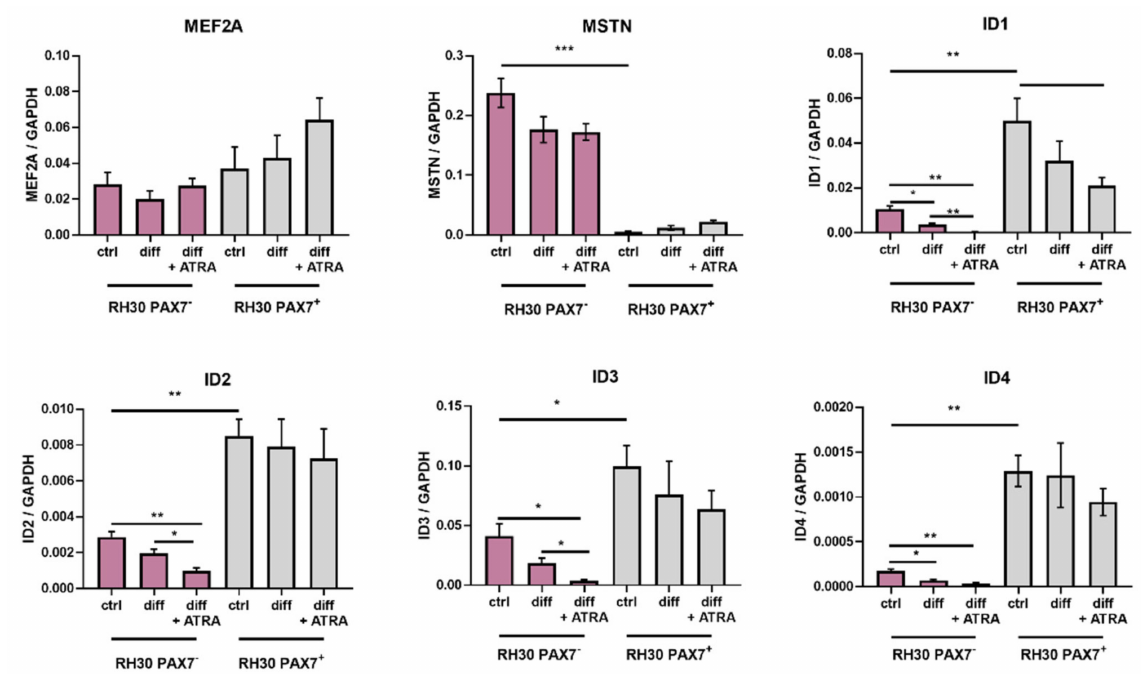
Figure 4. RH30 PAX7 − and PAX7 + subclones displayed differences in expression levels of transcription factors that regulate myogenic differentiation. RH30 subclones undifferentiated (ctrl) and differentiated in DMEM LG medium with 2% HS without or together with ATRA differed in expression levels of myogenic transcription factors and ID factors, n = 3. mRNA expression levels were evaluated with qPCR. Data were calculated with 2 − ∆ Ct method using GAPDH as a constitutive gene. The data on graphs show means ± SEM. * p < 0.05, ** p < 0.01, *** p <